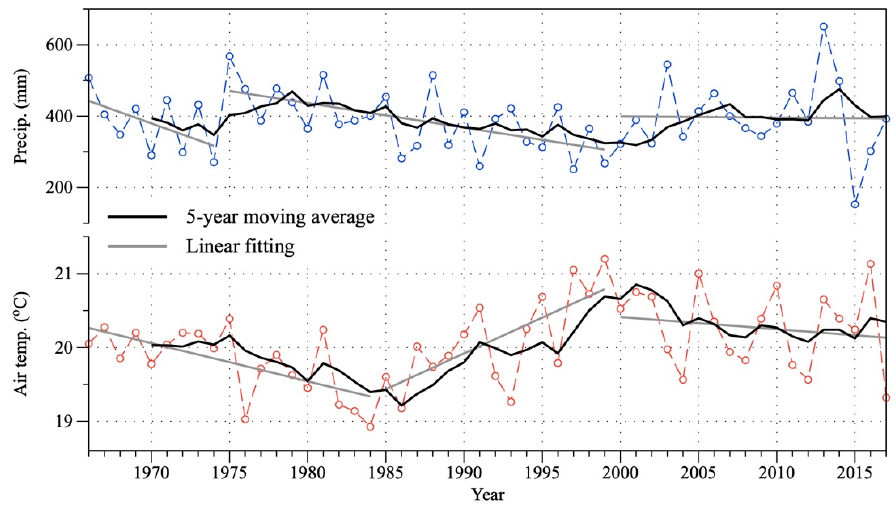
Figure 2. Time series of flood season’s rainfall and mean air temperature over the Yunyan River Basin from 1966 to 2017.